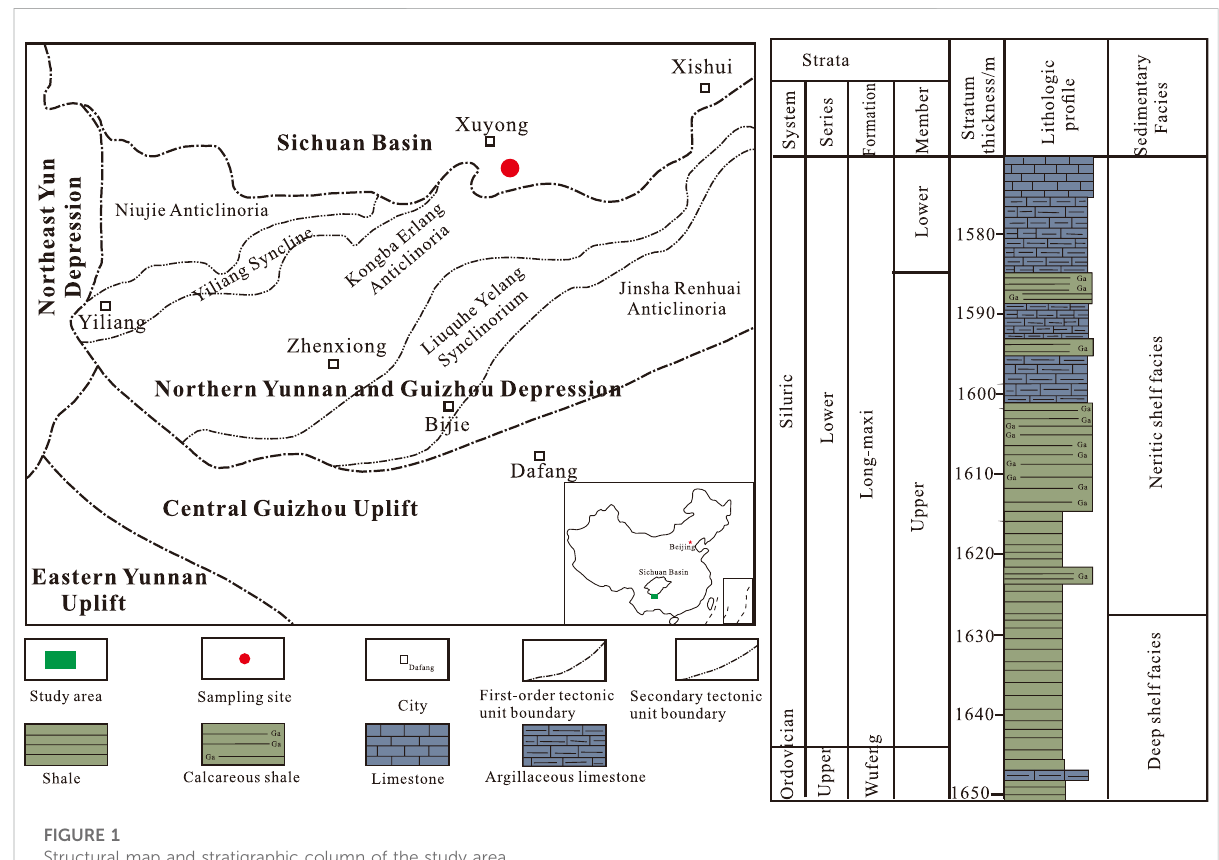
FIGURE 1 Structural map and stratigraphic column of the study